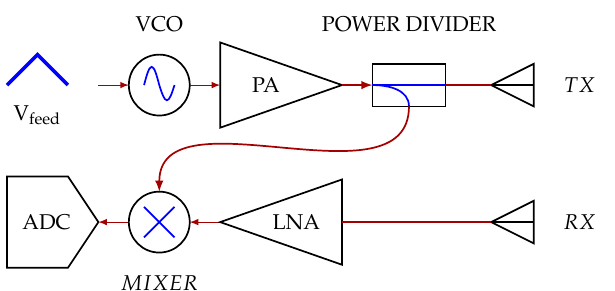
Figure 2. Block diagram of the designed radar. VCO, voltage controlled oscillator; PA, power amplifier; LNA, low noise